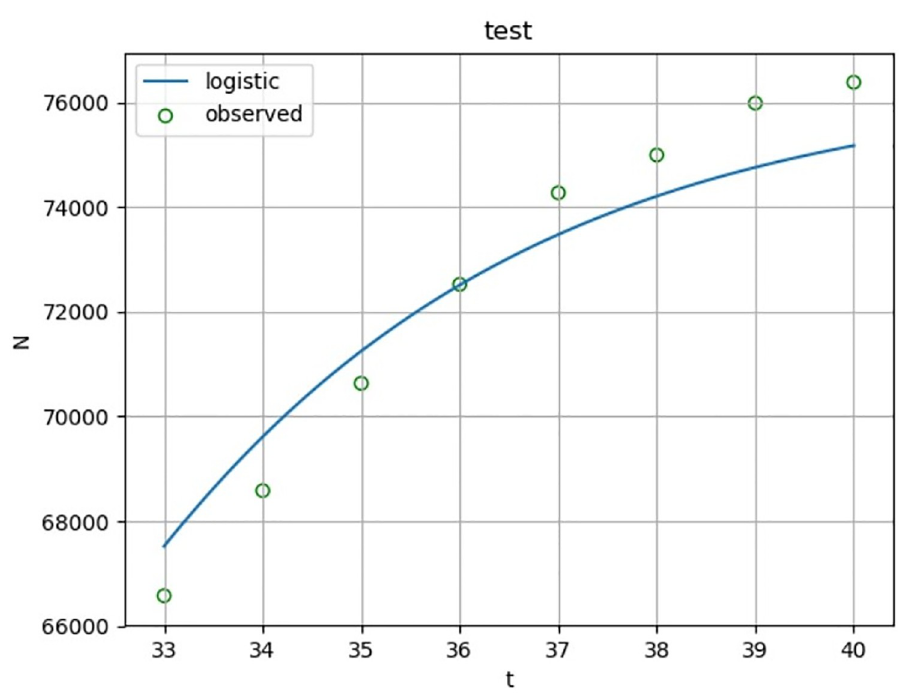
Fig 5. Logistic curve fitting diagram of cumulative confirmed cases of COVID-19. The cumulative confirmed cases of COVID-19 in China from February 14 to February 21, 2020 are used as a test set. SPSS is used to conduct. Logistic curve fitting for the daily accumulative confirmed number in this period to evaluate the effectiveness of the model.